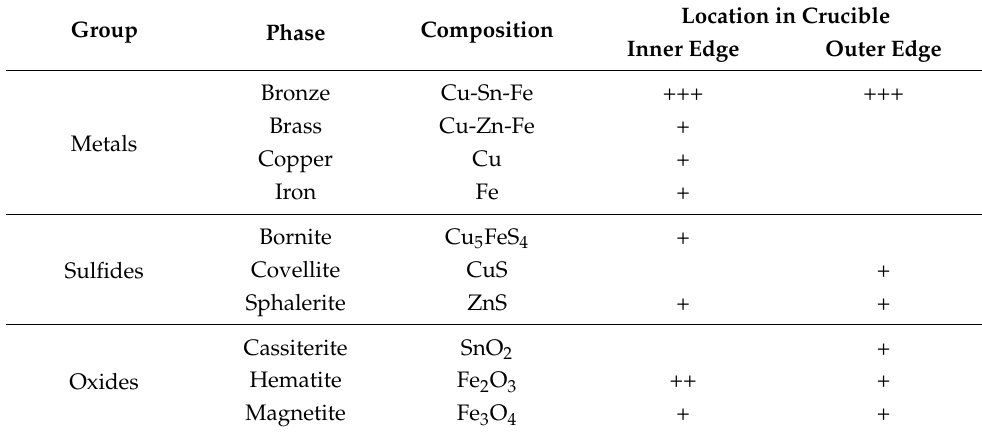
Table 1. Composition of metal phases recorded in the crucible by SEM-EDS and Raman spectroscopy analyses.